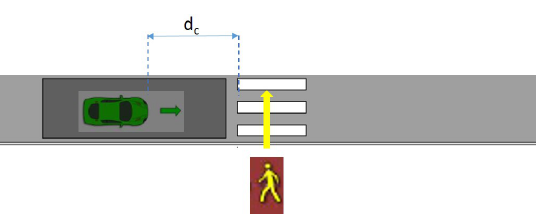
Figure 1. Classical crosswalk: one pedestrian and one car coming through a straight